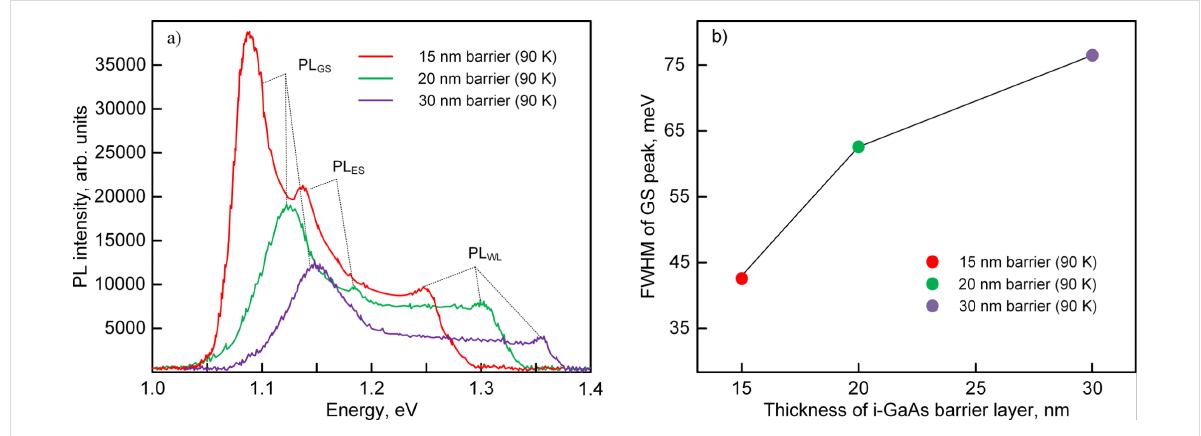
Figure 2: a) Photoluminescence spectra of the InAs/GaAs heterostructures with different thicknesses of the GaAs barrier layer; b) full width at half maximum of ground state photoluminescence peaks as a function of the thickness of the i-GaAs barrier layer.